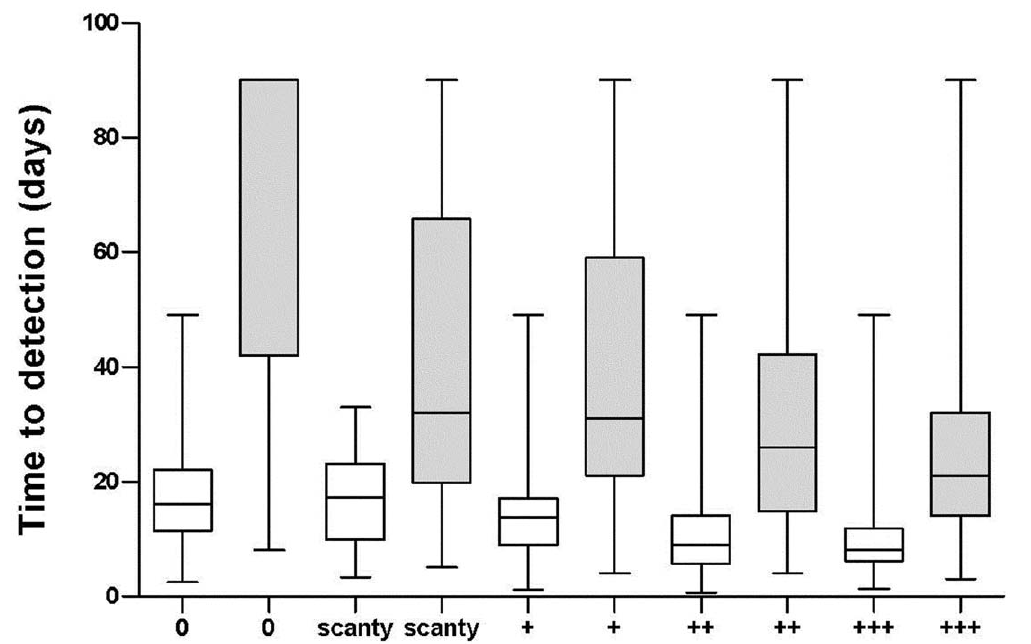
Figure 3. Time to Detection (TTD) of respiratory tract specimens cultured with the automated liquid culture BacT/ALERT MP (white bar) and with the Lo¨wenstein-Jensen medium (grey bar) in relation to AFB scoring of TB patients. TTD in days: median